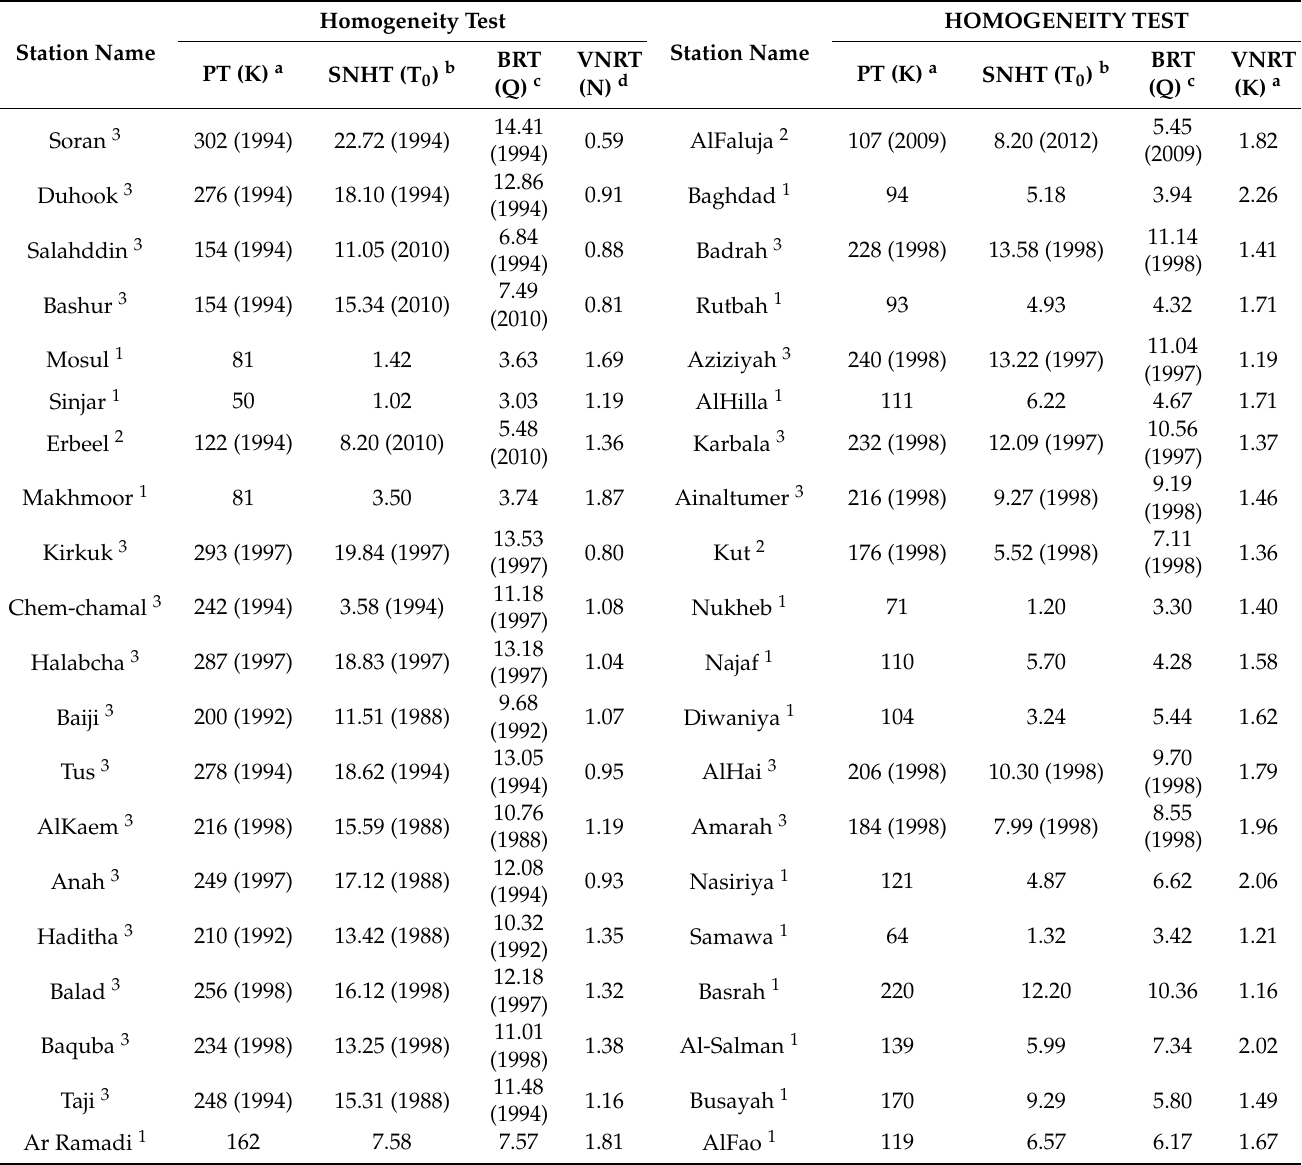
Table 3. Station addresses with corresponding homogeneity test results for meteorological data